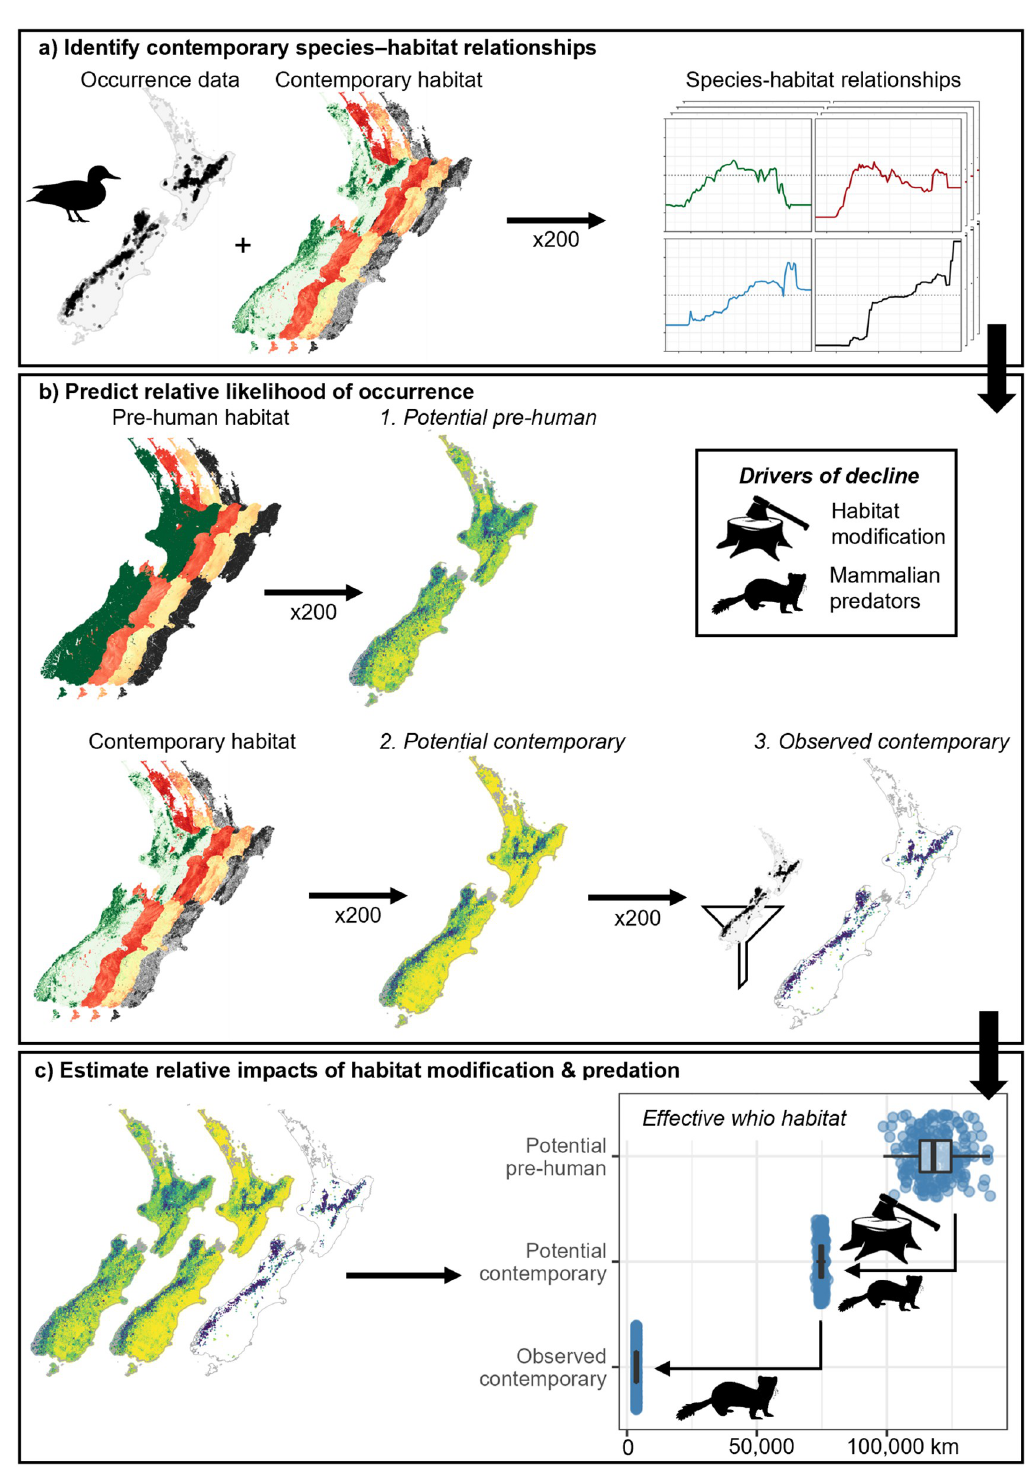
Fig 2. The approach used to assess the relative impacts of habitat loss and mammalian predation on whio range declines. a). Whio occurrence and contemporary habitat data were combined in 200 bootstrapped boosted regression tree (BRT) models to identify species-habitat relationships. b). We used these relationships to predict the relative likelihood of occurrence (RLO) of whio under two scenarios: potential pre-human with pre-human land cover and no mammalian predators; and potential contemporary with contemporary land cover and no mammalian predators. The observed contemporary results filtered the